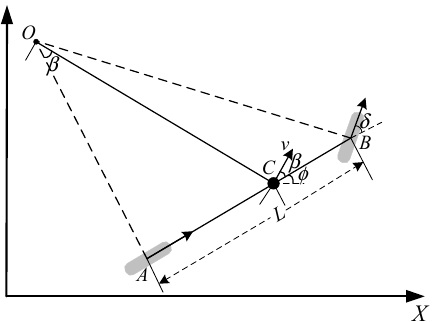
Figure 1. Kinematics Model of Bus Front Wheel Steering.